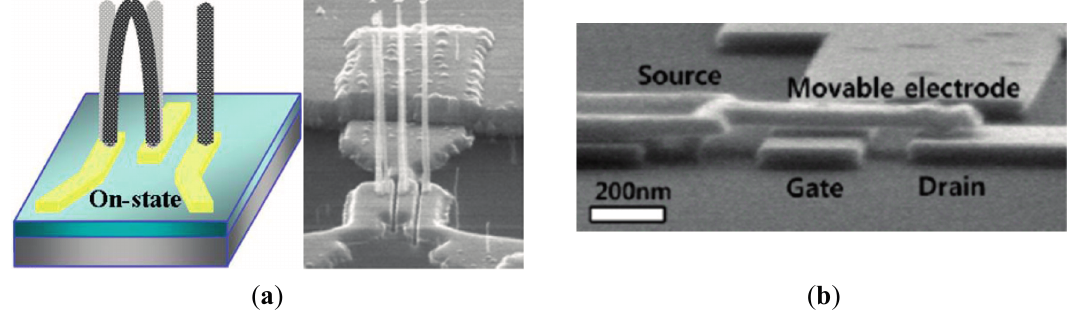
Figure 6. ( a ) First demonstration of NEM relay using MWCNT [29] (Reprinted with permission from [29], copyright 2005, AIP Publishing LLC). ( b ) Demonstration of “top-down” fabricated 3T relay developed in KAIST [42] (© 2009 IEEE, reprinted with permission from [42]).